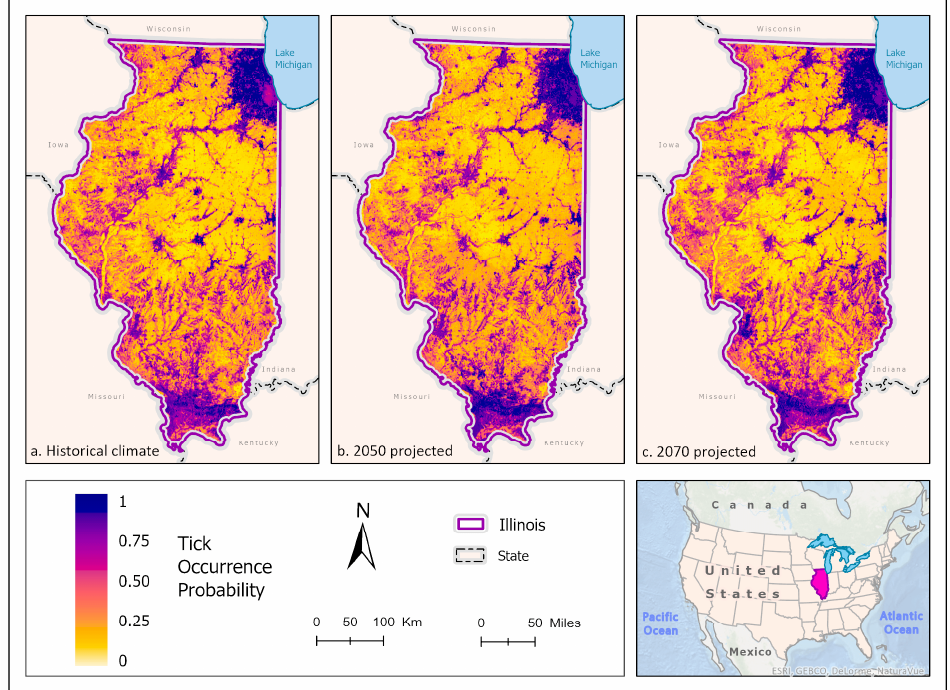
Figure 6. ( a ) Mean-weighted ensemble prediction of the probability of D. variabilis occurrence in Illinois under historical climate conditions. ( b ) Mean-weighted ensemble of predicted probability of D. variabilis occurrence in Illinois in 2050 projected climate Coupled Model Intercomparison Project phase 6 (CMIP6)/EC-Earth3-Veg Shared Socioeconomic Pathway (SSP) 585 (average from 2041 to 2060). ( c ) Mean-weighted ensemble of future predicted probability of D. variabilis occurrence in Illi- nois in 2070 projected climate (CMIP6)/EC-Earth3-Veg Shared Socioeconomic Pathway (SSP) 585 (average from 2061 to 2080). Darker colors indicate a higher likelihood of tick presence, per the tick occurrence probability scale. Inset map indicates the location of Illinois within the United States/North America.